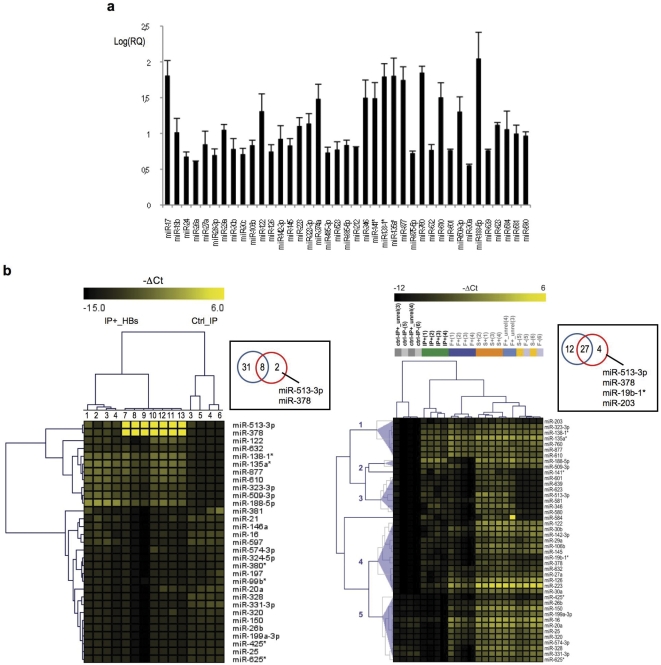
Identification of human miRNAs associated with serum HBsAg.(a) The circulating HBsAg-miRNA signature: average RQs were obtained from the comparative DDCT analysis. Values are reported in a bar plot as a logarithmic scale base 10 along with SD. (b) Differentially detected miRNAs between HBsAg positive immunoprecipitates (HBs-IP+) samples (left-most, n = 11; right-most, n = 4) and the group of control HBsAg negative immunoprecipiates (ctrl-IPs) (n = 4) were selected by Mann-Whitney test on –DCt values (left-most, p<0.1; right-most, p<0.05), and an unsupervised hierarchical cluster analysis was finally performed. Venn diagrams indicate the comparison among the pool of HBsAg-associated miRNAs obtained from the comparative DDCT analysis of panel a (blu circle) and the HBsAg-associated miRNAs obtained from the Mann-Whitney tests (red circle).